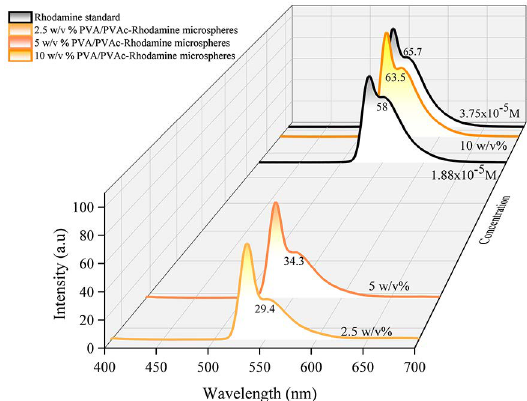
Figure 13. Fluorescence spectra of standard Rhodamine solutions 1.87 x 10 -5 M and 3.75 x 10 -5 M (black), and microspheres solutions 10 w/v %, 5 w/v % and 2.5 w/v %